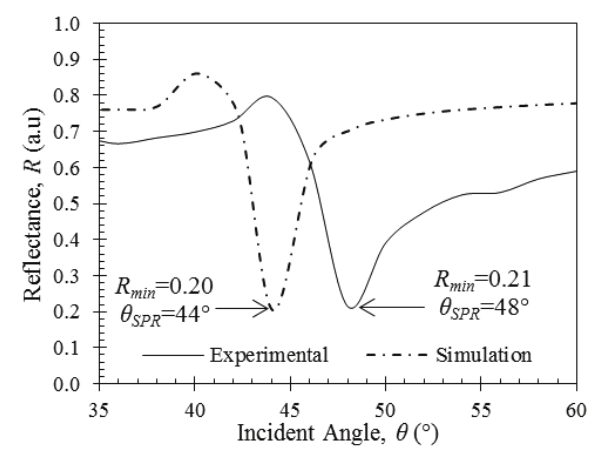
Fig. 8. Location of Brewster angle and critical angle for experimental and simulation results.